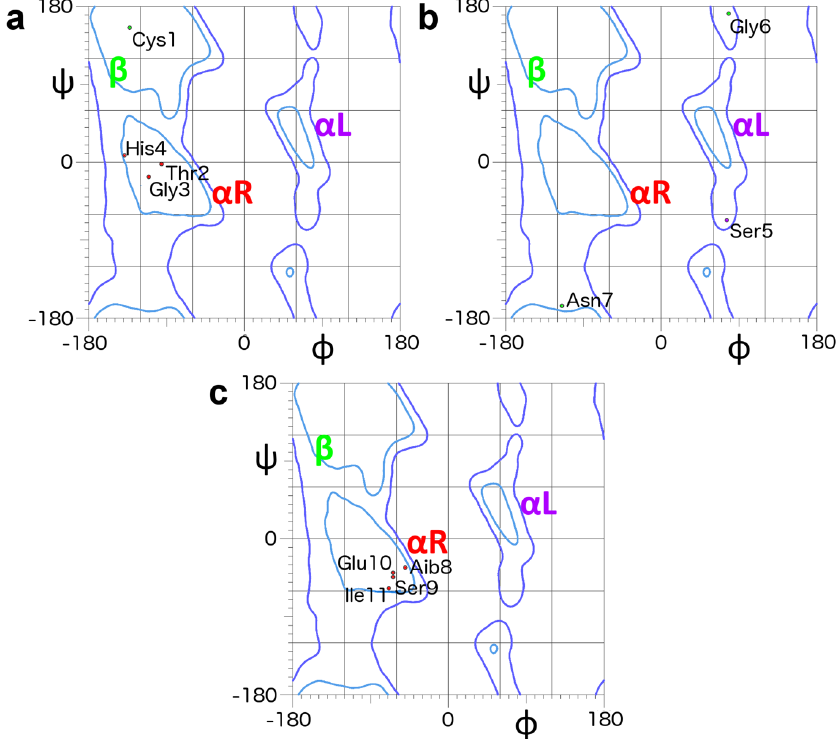
Figure 10. Ramachandran plots of the refined METP3 model. ( a ) Region from Cys 1 to His 4 encom- passing a type I α RS turn. ( b ) Ser 5 to Asn 7 in the extended region. ( c ) Terminal helical region from Aib 8 to Ile 11 . Color-coded labels define the most representative areas of the Ramachandran plot: right-handed α -helix/red, ß-strand/green, left-handed α -helix/violet. ϕ , ψ values of chain A are reported. Molprobity [71] has been used to generate the plot (http://molprobity.biochem.duke.edu/, accessed on 15 September 2020).